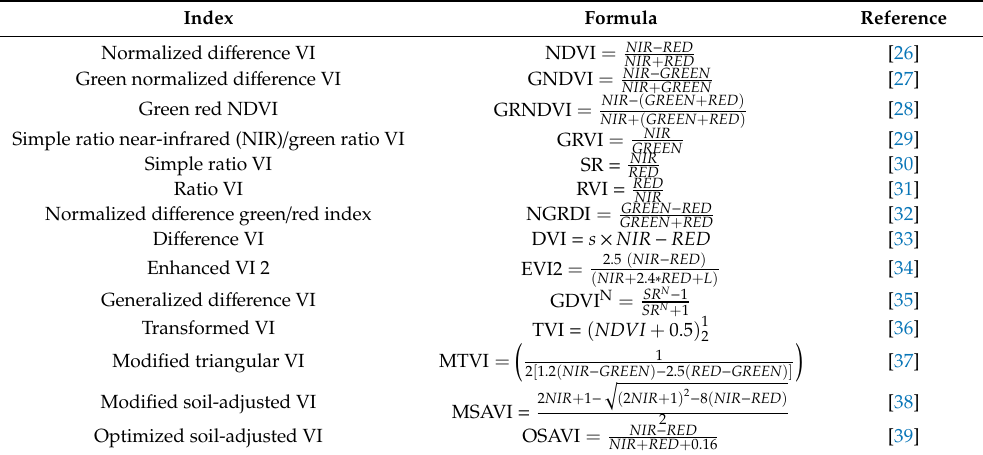
Table 1. Summary of vegetation indices (VIs)